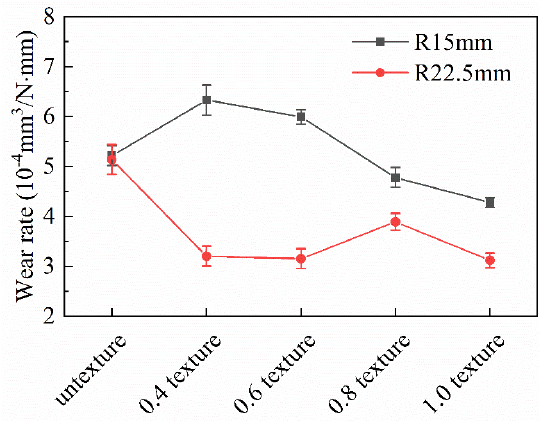
Figure 6. Wear rate of different samples. According to Table 4 and Table 5, the total number of collisions of the 0.8 mm groove texture at the 22.5 mm friction radius reached 24,000, and the total climbing height is 408 mm. The minimum average friction coefficient is σ =0.745. The lowest wear rate can be seen for the 1.0 mm texture with a friction radius of 22.5 mm, and the lowest wear rate is ω =3.118× 10 (cid:2879)(cid:2872) 𝑚𝑚 (cid:2871) / 𝑁 (cid:3401) 𝑚𝑚 . At this time, the total number of collisions is 24,000, and the total climbing height is 499.2 mm, but the maximum friction coefficient reached is σ = 0.898. From the friction ‐ reducing and wear ‐ resistance mechanisms of a conventional groove texture, the reason the groove ‐ textured surface has better friction reduction and wear resistance than the untextured surface may be that the wear debris on the groove ‐ textured surface is removed with friction during the friction process. A part of the wear debris from the groove texture is captured and stored, thus reducing the further aggrava ‐ tion of abrasive wear. Some of the debris collides and rolls. Under the same test parame ‐ ters, the surface friction without texture gradually increases with the friction test. This is mainly because the wear debris cannot be discharged in time during the friction process. The generated wear debris forms three ‐ body wear on the surface of the friction pair. The heat generated by friction is increased so that the wear is constantly aggravated. This is a conventional wear mechanism, but it is not comprehensive. Next, we will further analyze the friction mechanism of the groove texture. In fact, in the actual friction process of the groove texture, there are different contact friction stages. According to the order of friction time, we can divide it into the first contact friction stage and the second contact friction stage. In the first contact friction stage, the contact of the friction pair conforms to the macroscopic Hertz contact in Figure 1. At the same time, friction collision and friction heat generation are coupled. In order to facilitate the reader’s understanding, we introduce the concepts of climbing and climbing height. Climbing refers to the slope that the ball slides along from the groove to the disc surface in the sliding direction during friction. The climbing height is the vertical height of the ball from the deepest position of the groove to the surface of the disc. We consider that the untextured surface is a groove texture with a groove diameter of 0 mm. So, this research is equivalent to the experimental comparison of five groove textures with different groove widths under the same friction experimental parameters. During the initial friction between the ball and groove texture, the climbing contact diagram of a ball with a diameter of 9.525 mm and a surface texture with groove widths of 0 mm (untextured), 0.4 mm, 0.6 mm, 0.8 mm and 1.0 mm, respectively, is shown in Figure 7. The moving tracks of the contact points of the five width textures in the climb ‐ ing process are respectively represented by 𝑎 (cid:2868) , 𝑎 (cid:2868) . (cid:2872) , 𝑎 (cid:2868) . (cid:2874) , 𝑎 (cid:2868) . (cid:2876) , and 𝑎 (cid:2869) . (cid:2868) . It can be seen that, with an increase in texture width, the climbing height gradually increases.